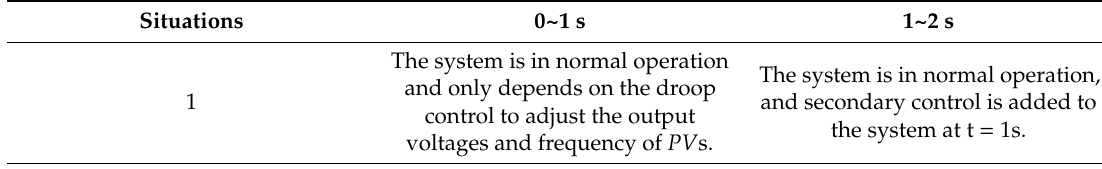
Table 3. The operation process in Case